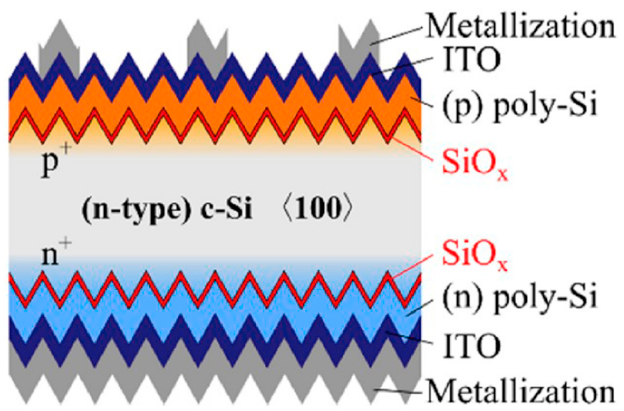
Figure 8. Double-sided structure of TOPCon solar cell. Reprinted/adapted with permission from Ref. [53]. 2020, Elsevier.